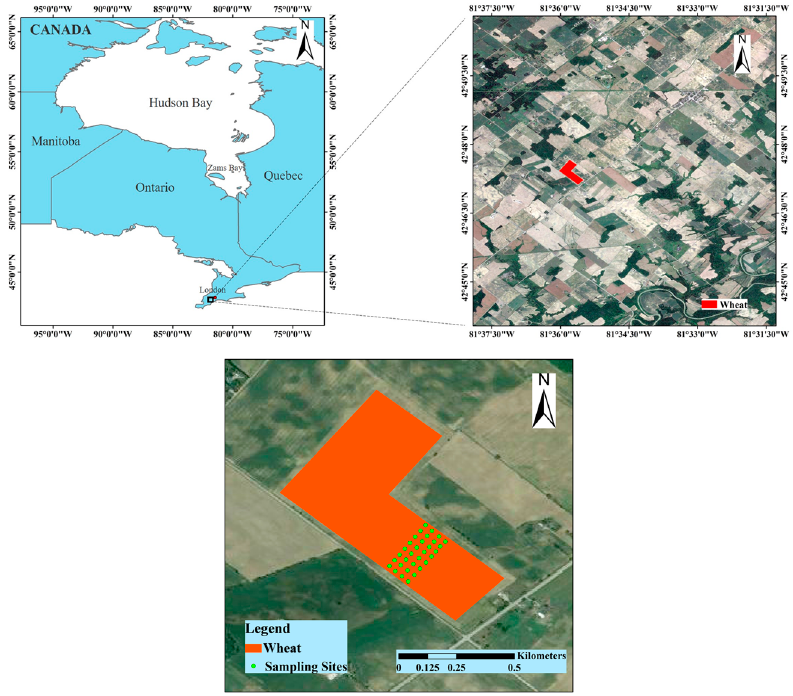
Figure 1. Location of the study area.